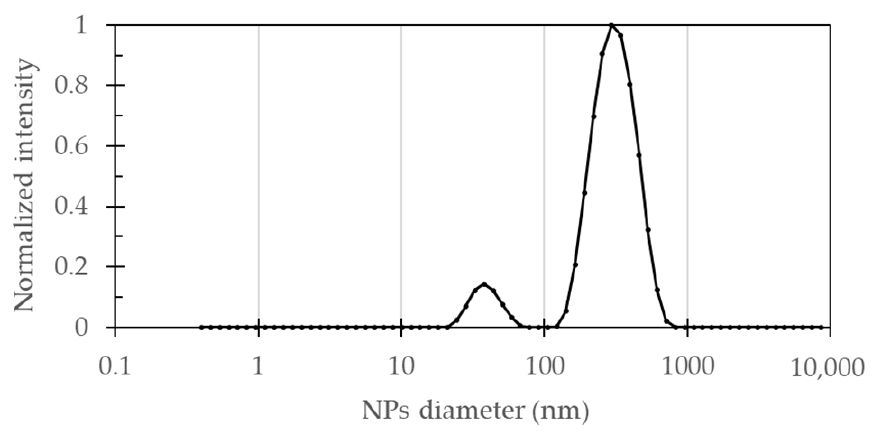
Figure 1. DLS result of particle size distribution for bare Fe 3 O 4 NPs nanoparticles in aqueous suspension. The first peak from left to right is centered at 39.4 ± 9.1 nm (8.9%) while the second one is at 323.6 ± 107.2 nm (91.1%).